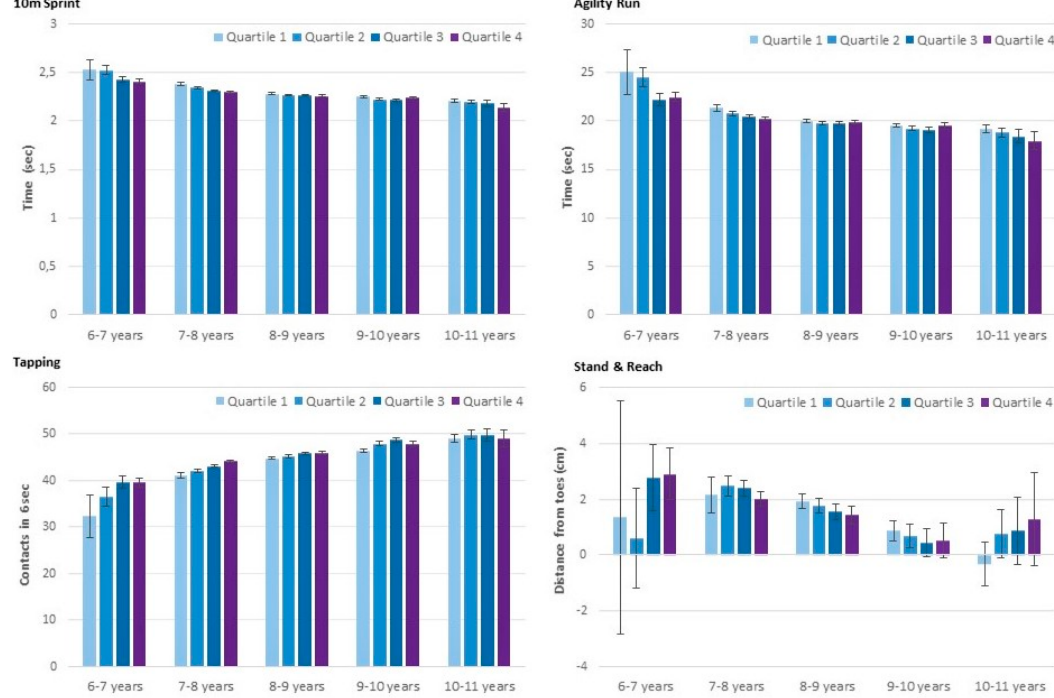
Figure 2. Speed, agility and flexibility by age-group and age-specific quartile. Values are means, adjusted for sex, with a 95% confidence interval.